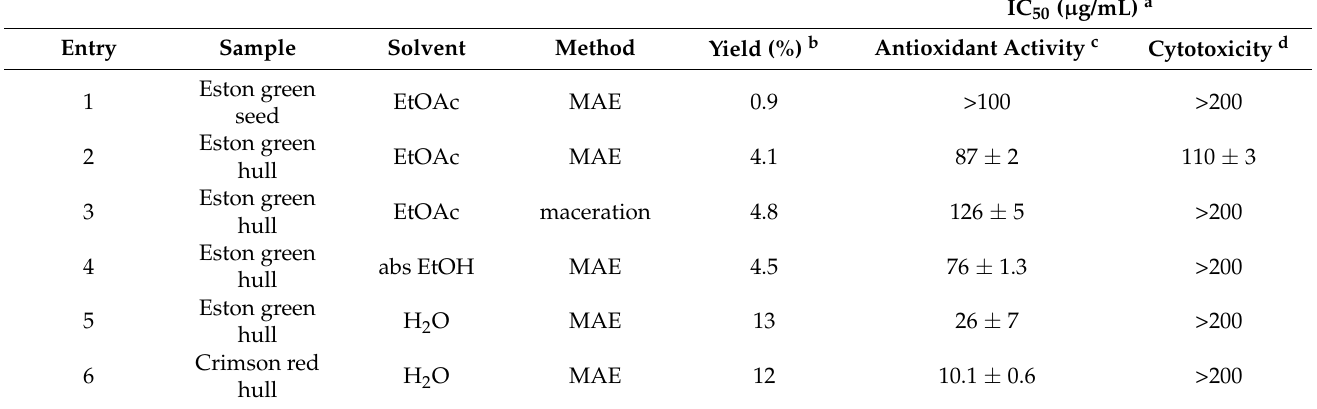
Table 1. Antioxidant activity of seeds and hulls lentil extracts, obtained with different solvents, on SH-SY5Y